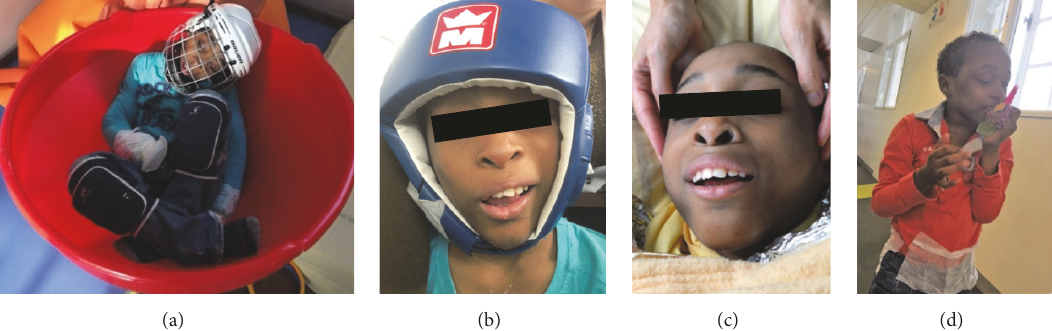
Figure 4: Clinical improvement during hospitalization with decrease of restrictive equipment ((a) to (d)): asleep in the top seat (hard helmet mesh, mittens, and protective knee) (a); wearing soft helmet (b); singing during a therapeutic body wrap session with sensory touch (c); walking without helmet